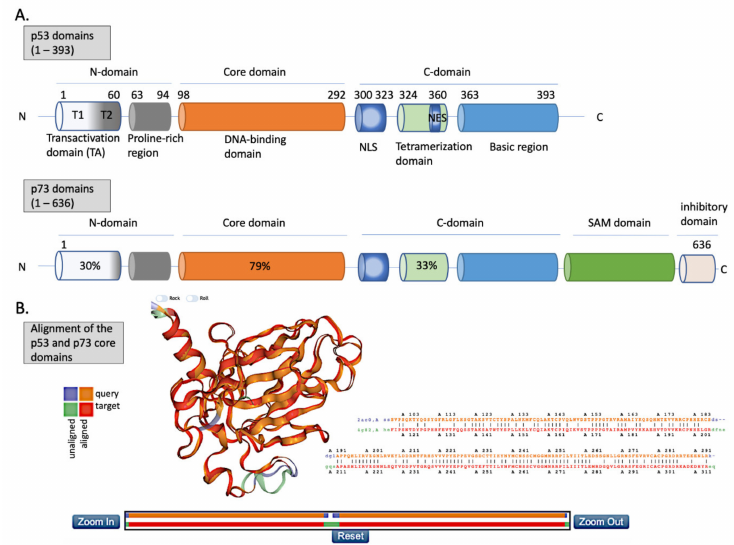
Figure 2. The structures of p53 and p73. ( A ) Upper panel—domains in p53